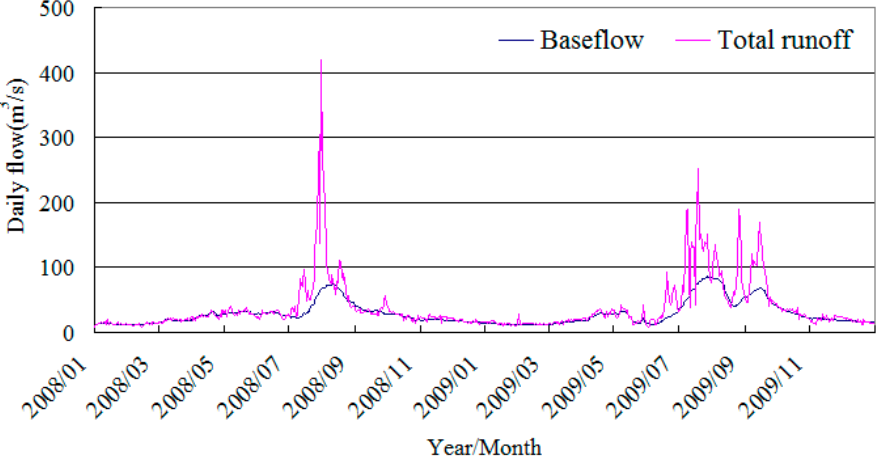
Figure 4. The simulated baseflow and observed runoff in the study area during 2008–2009.